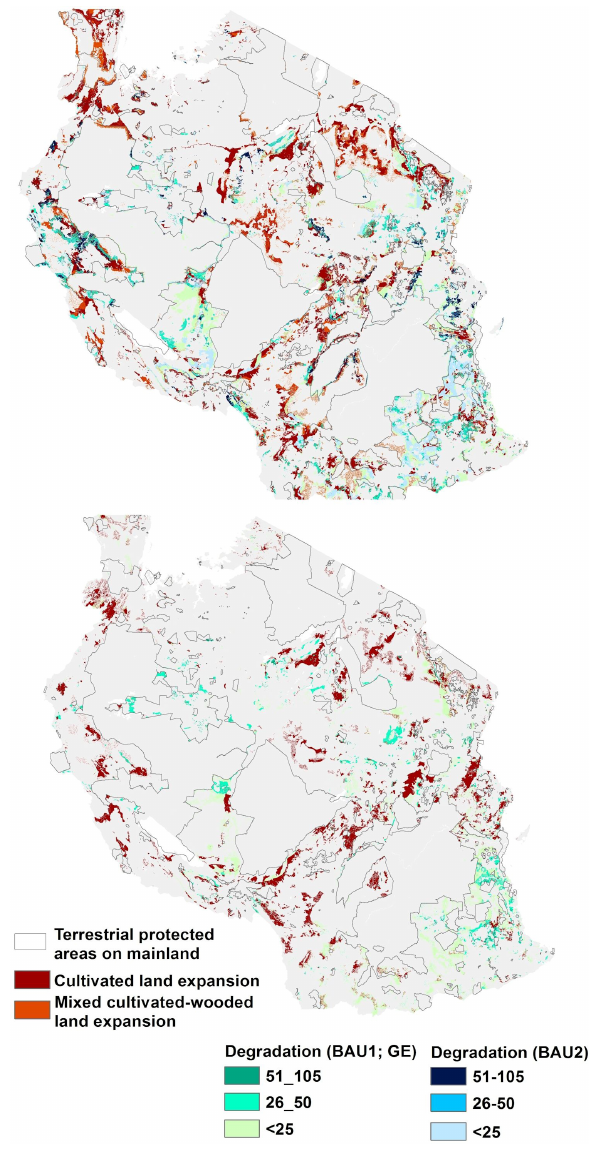
Fig. 4 . Distribution of possible future land use and land cover changes under business as usual (BAU) and green economy (GE) scenarios. Potential cropland expansion is represented in red, expansion of mixed cultivated-wooded land (BAU2 only; see Table 2) in orange, and degradation in shades of blue (BAU2) and green (BAU1 and GE). Areas where land use and cover are not changing under these scenarios are represented in grey, and grey lines delimit terrestrial protected areas from the World Database on Protected Areas (IUCN and UNEP- WCMC